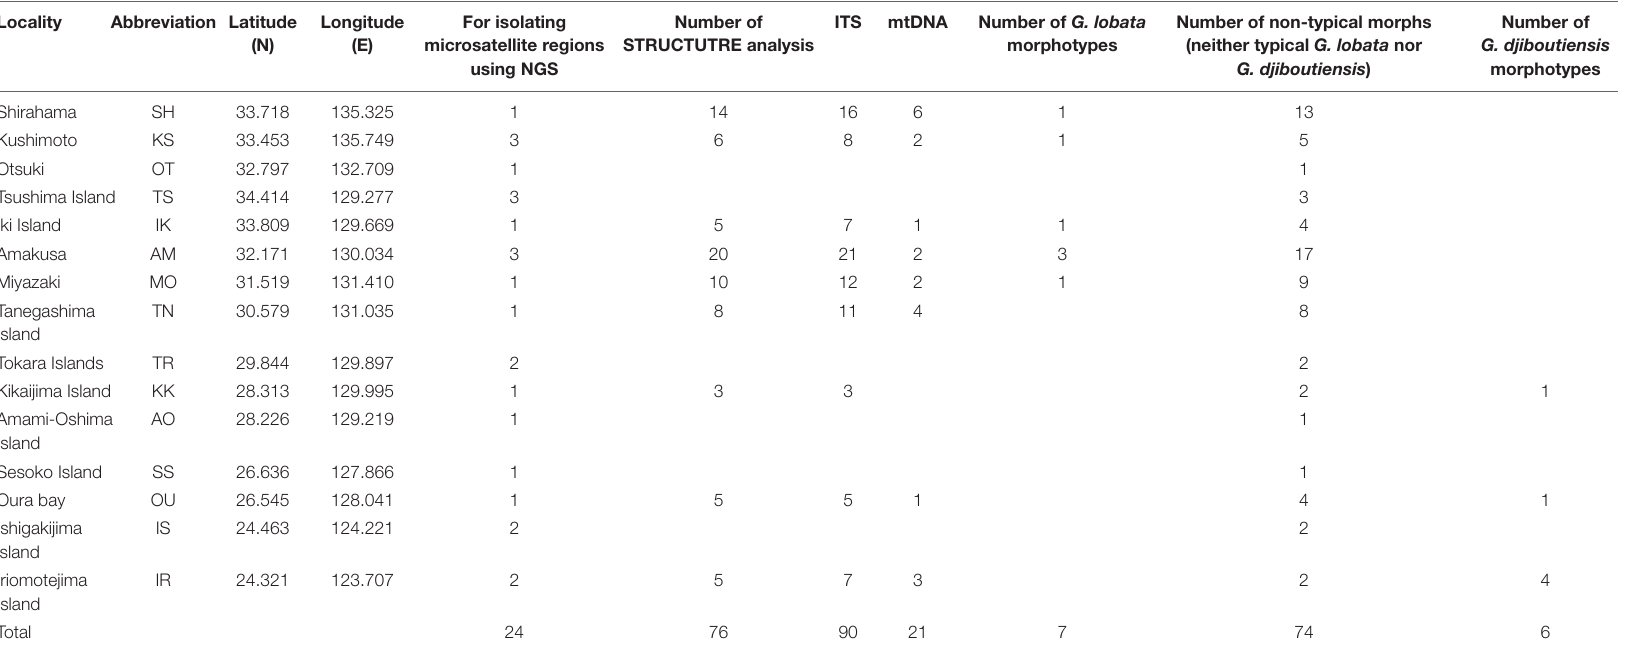
TABLE 1 | The list of G. lobata-like and G. djiboutiensis-like samples used in this study. Locality Abbreviation Latitude